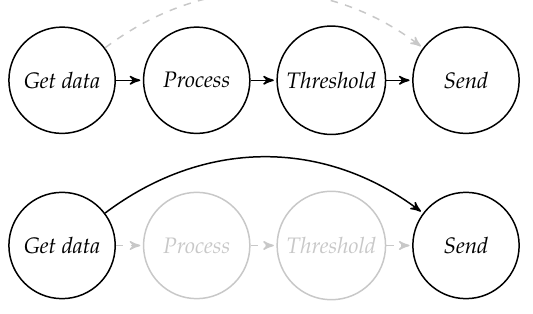
Figure 6. Two possible configurations of a generic